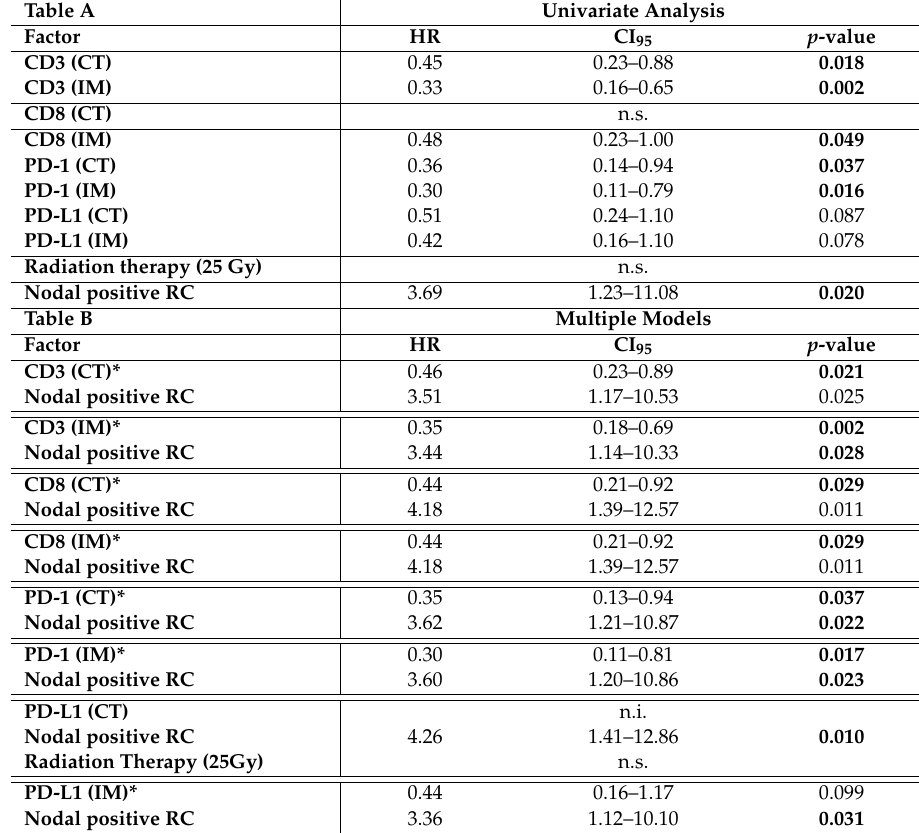
Table 6. Univariate and multiple Cox Regression analysis for overall survival of rectal cancer patients quantified using analogue quantification for TC densities (full sections).